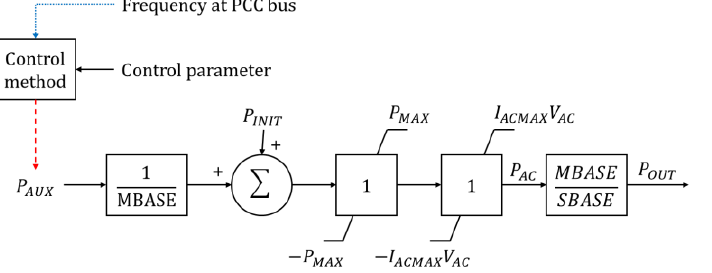
Figure 5. Power system simulator for engineering (PSS/E) CBEST model-based block diagram of battery energy storage system (BESS).